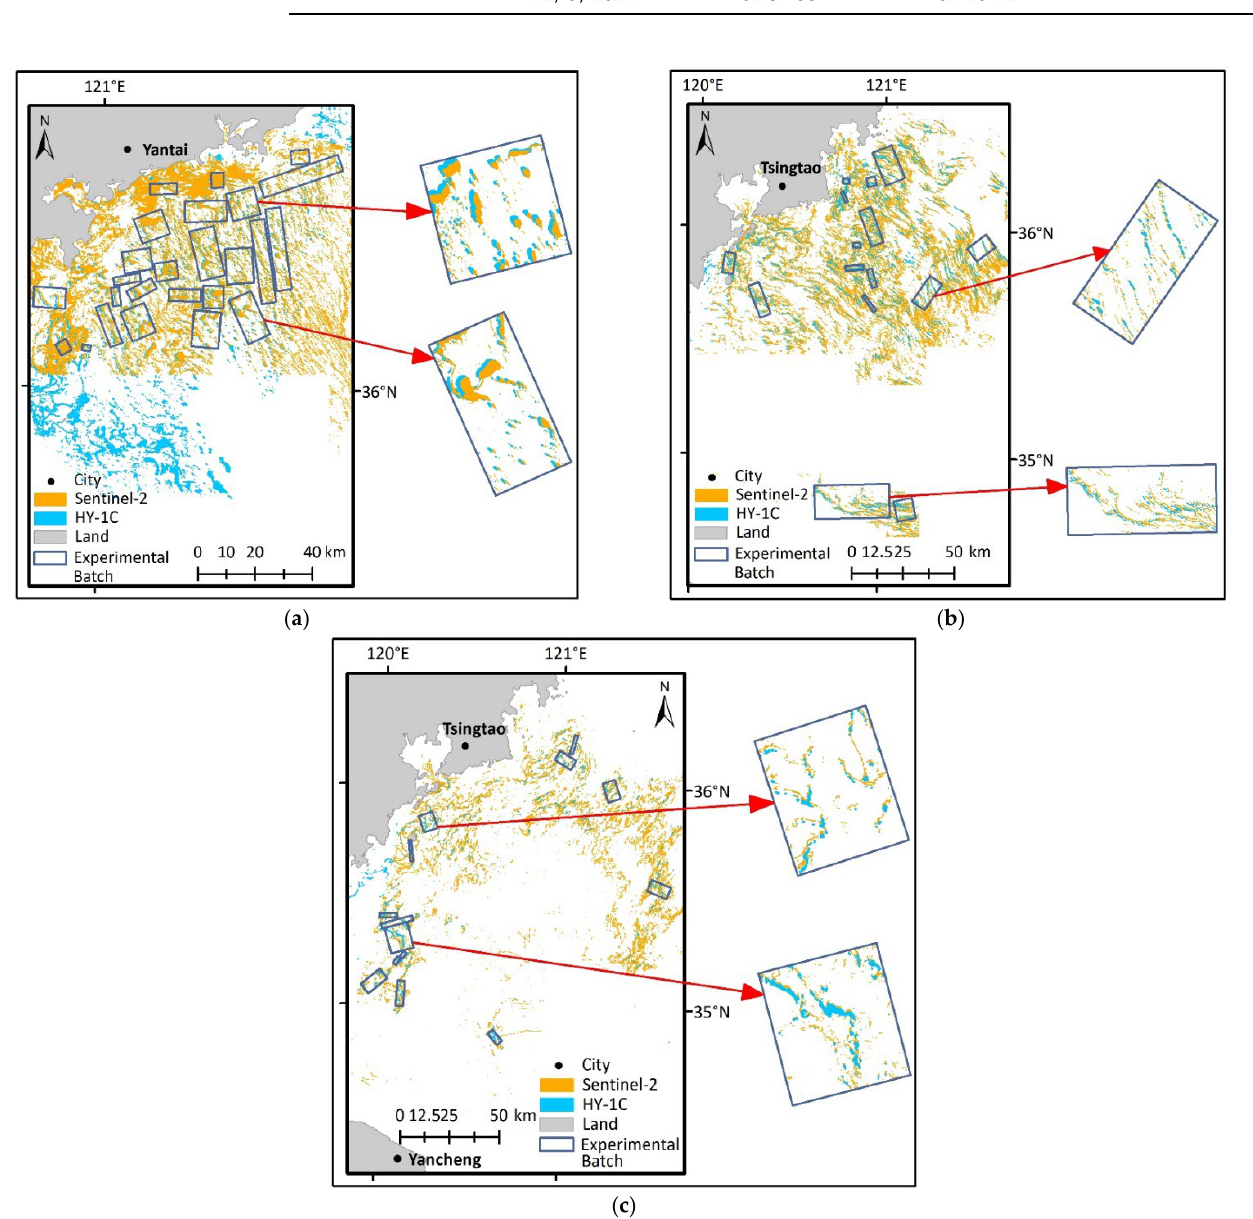
Figure 3. Experimental patch distribution for M HS establishment and verification. ( a ) Distribution of modeling patches on 2 July 2021. ( b ) Distribution of verifying patches on 17 July 2021. ( c ) Distribution of verifying patches on 11 August 2021.